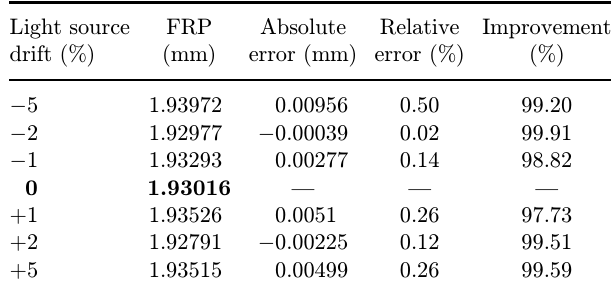
Table 8. Errors of light source drift at di®erent levels. Light source drift (%)